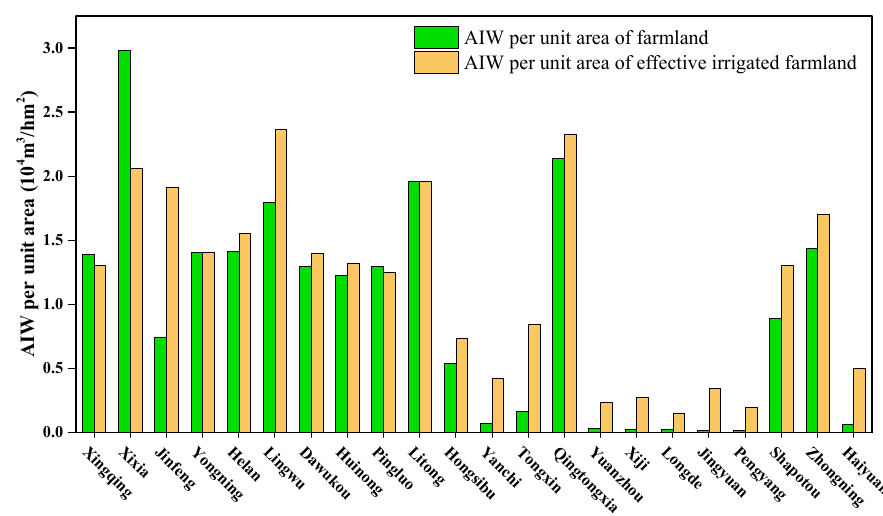
Figure 8. Annual mean agricultural irrigation water use per unit area.